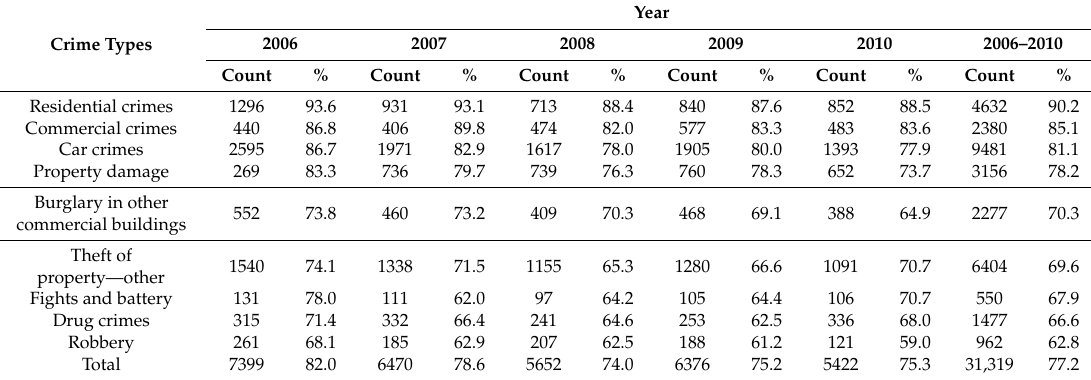
Table 2. Count and percentage of successfully geocoded crimes by type and